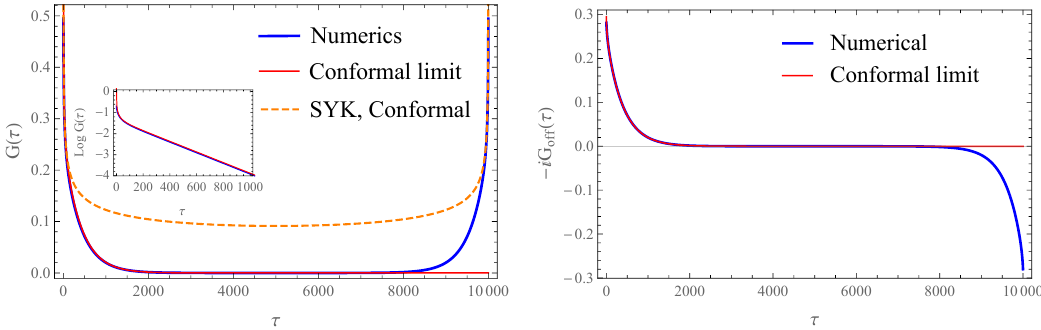
Figure 6 . The plot of the correlation functions for q = 8, (cid:12) = 10000, J = 1 and (cid:22) = 0 : 005 mass deformed SYK model. Left : the plot of the diagonal correlation functions. We plot the numerical solution for the Schwinger-Dyson equation, the conformal limit and the conformal limit of the SYK model. Right: the plot of the o(cid:11) diagonal correlation functions. We plot the numerical solution and the conformal